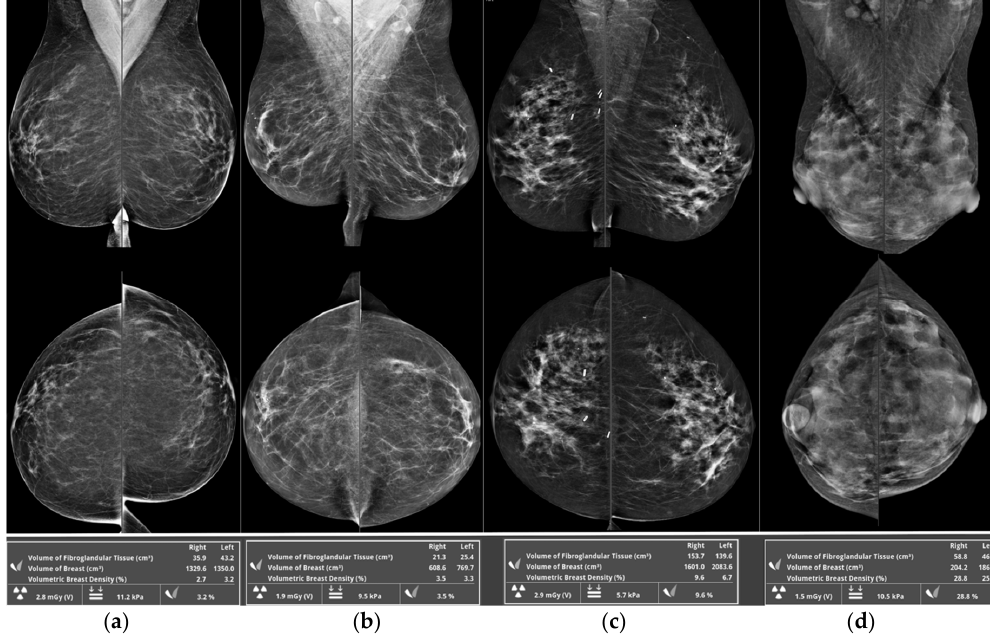
Figure 1. Qualitative mammographic breast density categories according to the fourth edition BI-RADS atlas (A = almost entirely fatty ( a ); B = scattered fibroglandular densities ( b ); C = heterogeneously dense ( c ); D = extremely dense ( d )) with corresponding automated percent density measurements allocated by Volpara software into Volpara Density Grades (VDGs) (VDG 1 = 0.0–4.4% density, VDG 2 = 4.5–7.4%, VDG 3 = 7.5–15.4%, VDG 4 ≥